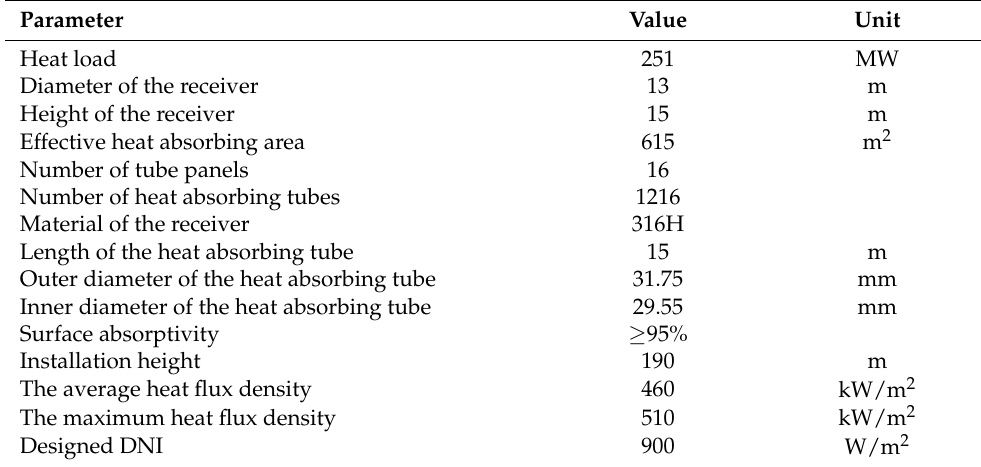
Table 1. Parameters of the molten salt receiver and collector